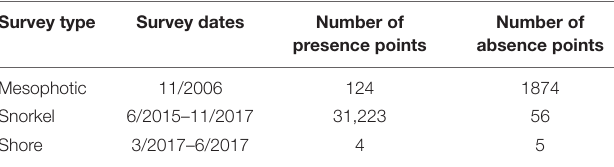
TABLE 1 | Raw observational data survey